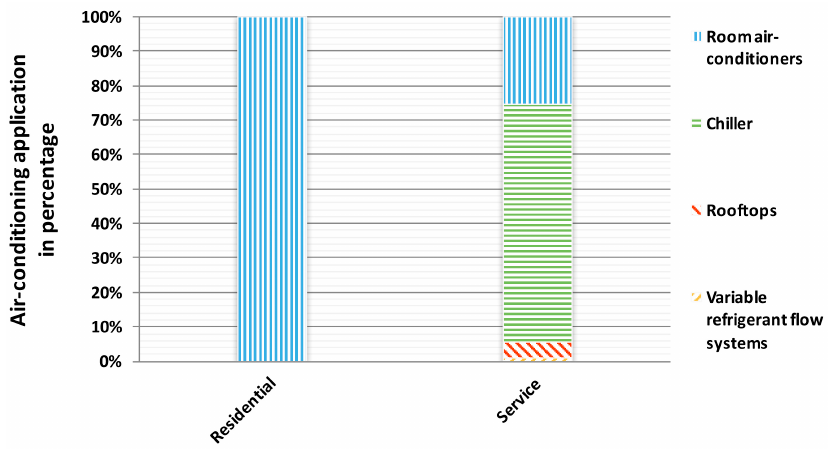
Figure 5. Distribution of installed AC application per type, residential and service sectors, EU15 [13,43,44].